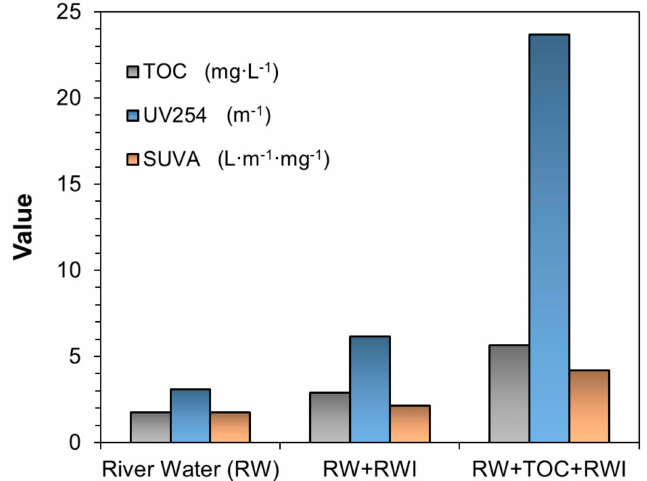
Figure 6. TOC, UV254, and Specific UV Absorbance (SUVA) values of three simulated raw water samples. (For river water conditions please refer to Table 1, for RW + RWI and RW + TOC + RWI, initial pH ≈ 7.50, turbidity = 70.00 NTU, temperature = 21 ◦